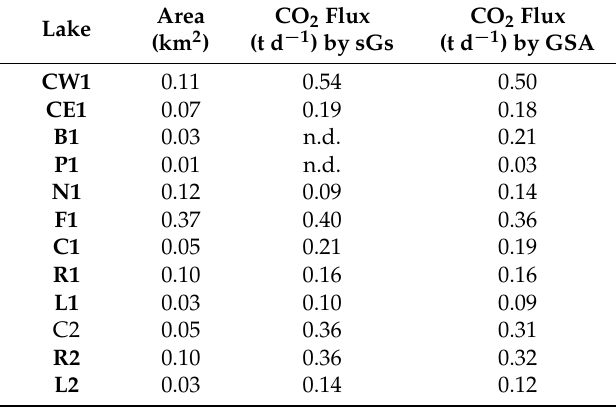
Figure 7. E-type CO 2 flux maps for the Flores lakes: ( A ) Comprida; ( B ) Rasa; and ( C ) Lomba lakes in the second survey (UTM–WGS84, zone 25S; interpolation method—sGs).